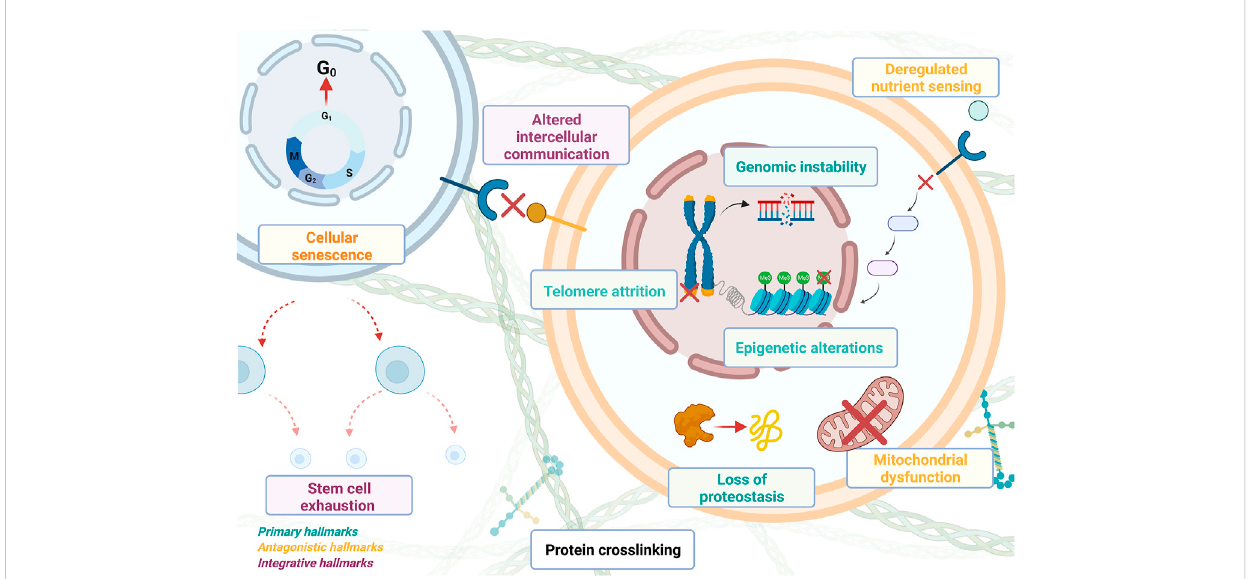
FIGURE 1 Summary of the hallmarks of aging. Primary hallmarks of aging, the primary causes of cellular damage, include genomic stability, epigenetic alterations, loss of proteostasis, and telomere attrition. Antagonistic hallmarks (this refers to factors that originated from body responses to the damage itself but end up exacerbating it) include mitochondrial dysfunction, deregulated sensing, and cellular senescence. Integrative hallmarks of aging (that result from the cumulative action of the previous two groups and are the main determiners of the functional decline) include stem cell exhaustion and altered intercellular communication. Each ofthese hallmarks has been thefocus ofintensive researchto understand their involvementinthedecline ofbiologicalfunctions.ML/AItechnologiesareusedtodeepenourunderstandingofthemanycomponentsthatareinvolved.Thisknowledgecanhelpto improve not only our understanding of these mechanisms taken separately but also how the interplay between them